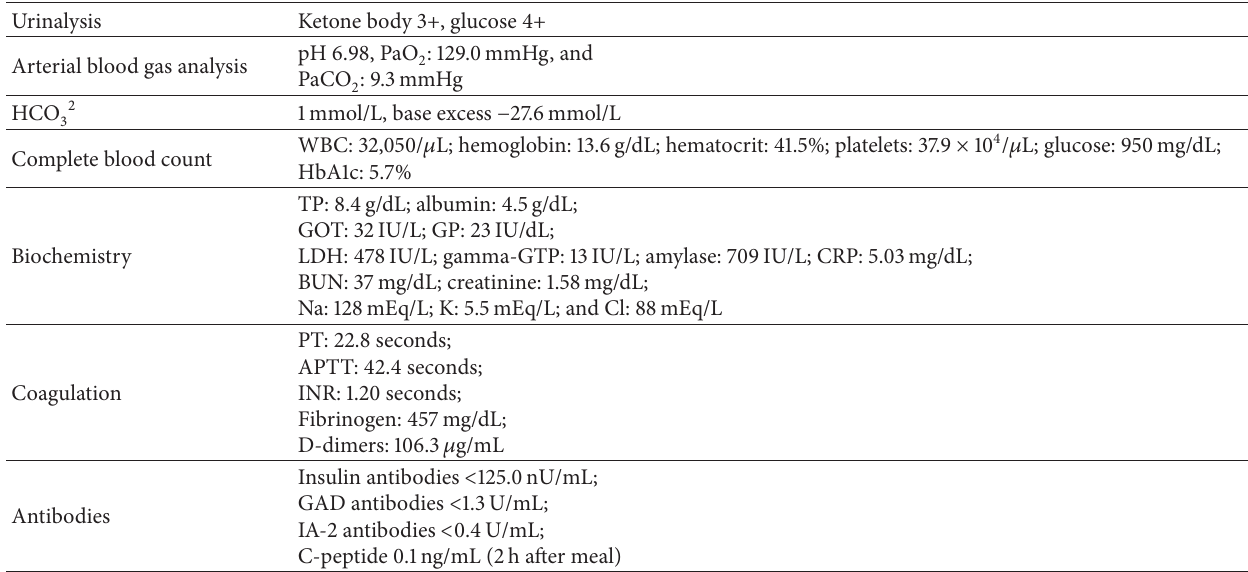
Table 1: Laboratory findings upon admission.